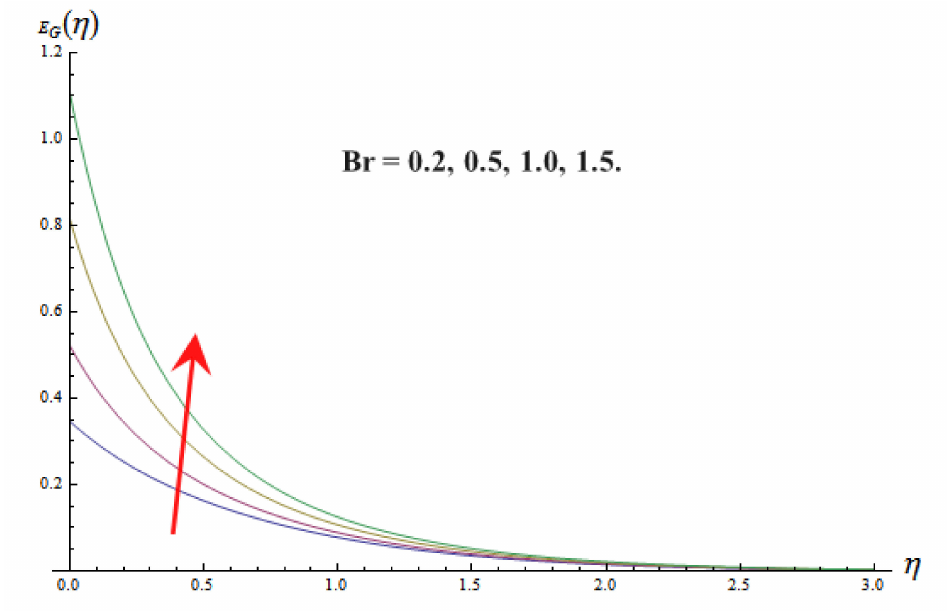
Figure 11. Impact of Br on E G ( η ) keeping Γ = 0.5, Ha = 0.2, Br = 2, λ = 2, Ec = 0.2, Rd = 2, β 1 = 0.2, λ 1 = 0.2, K ∗ = 2.